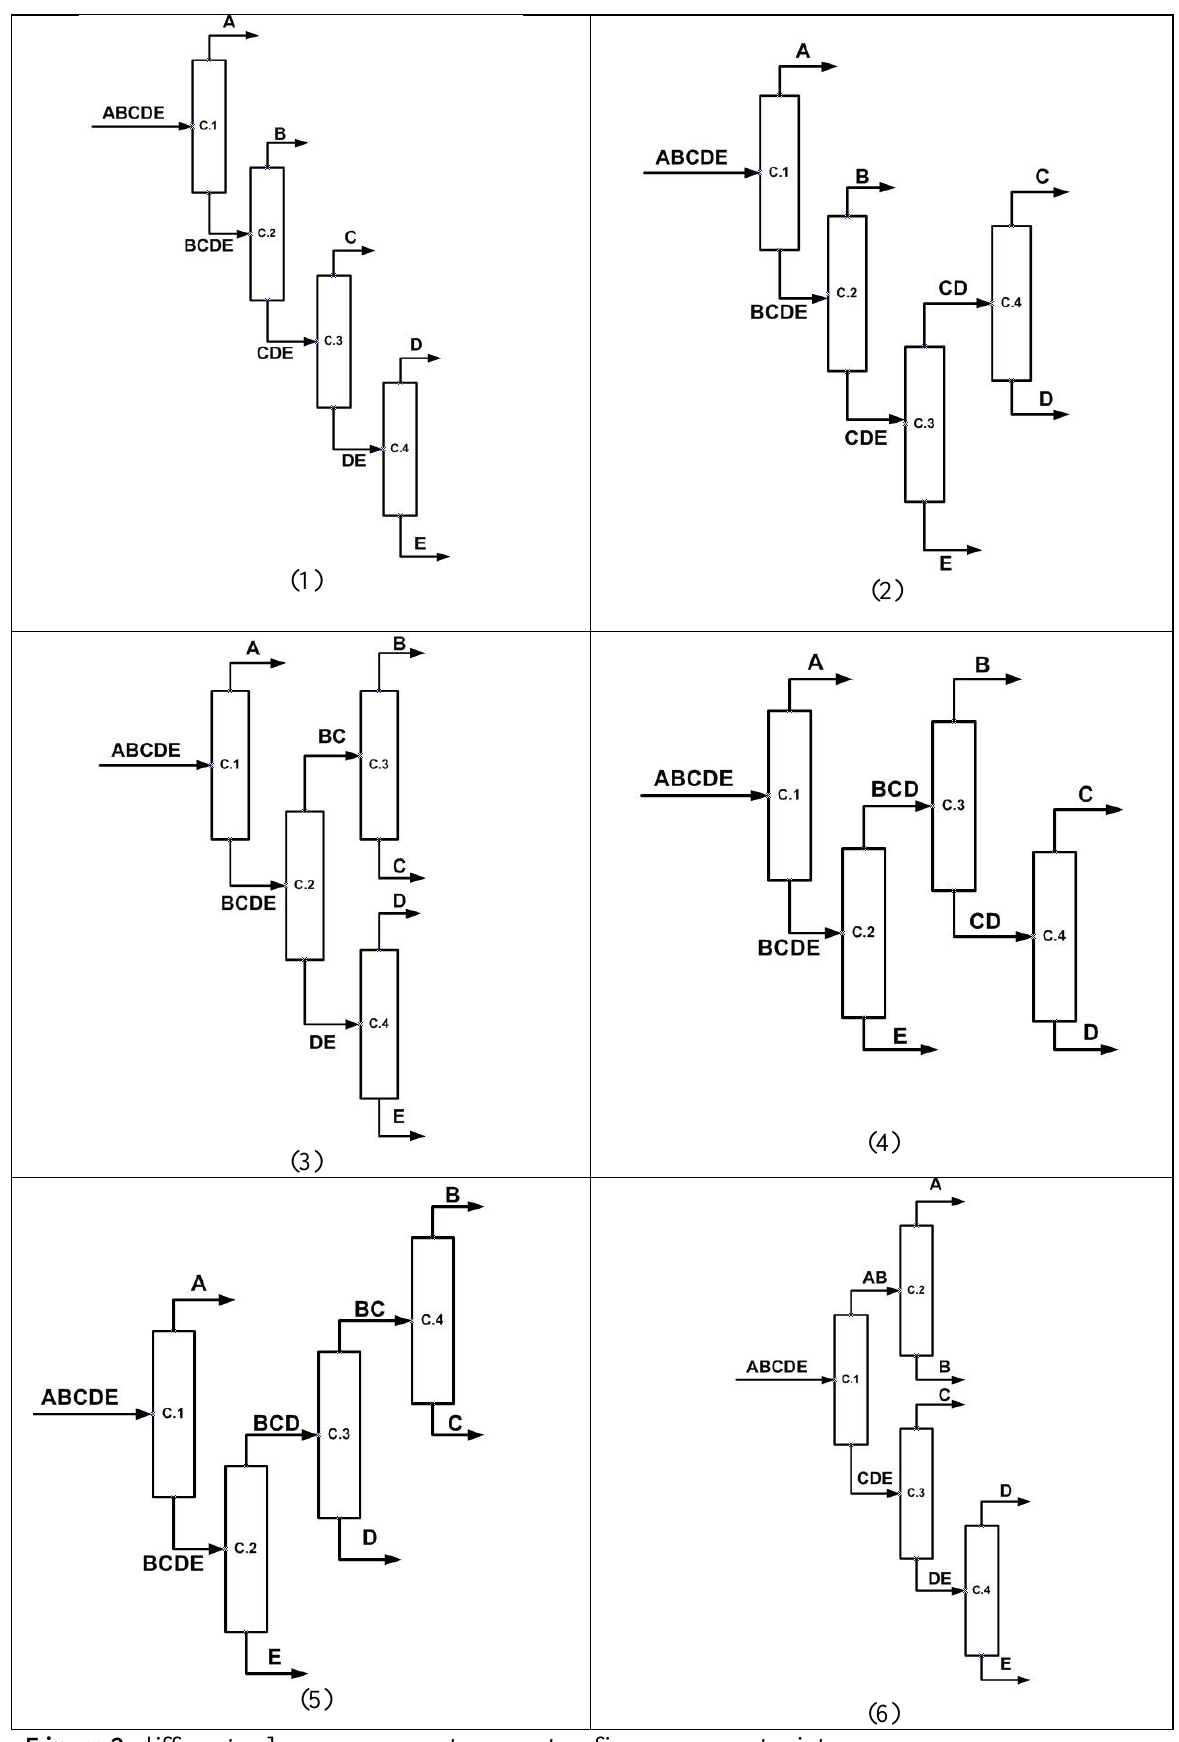
Figure 2 . different column sequences to separate a five-component